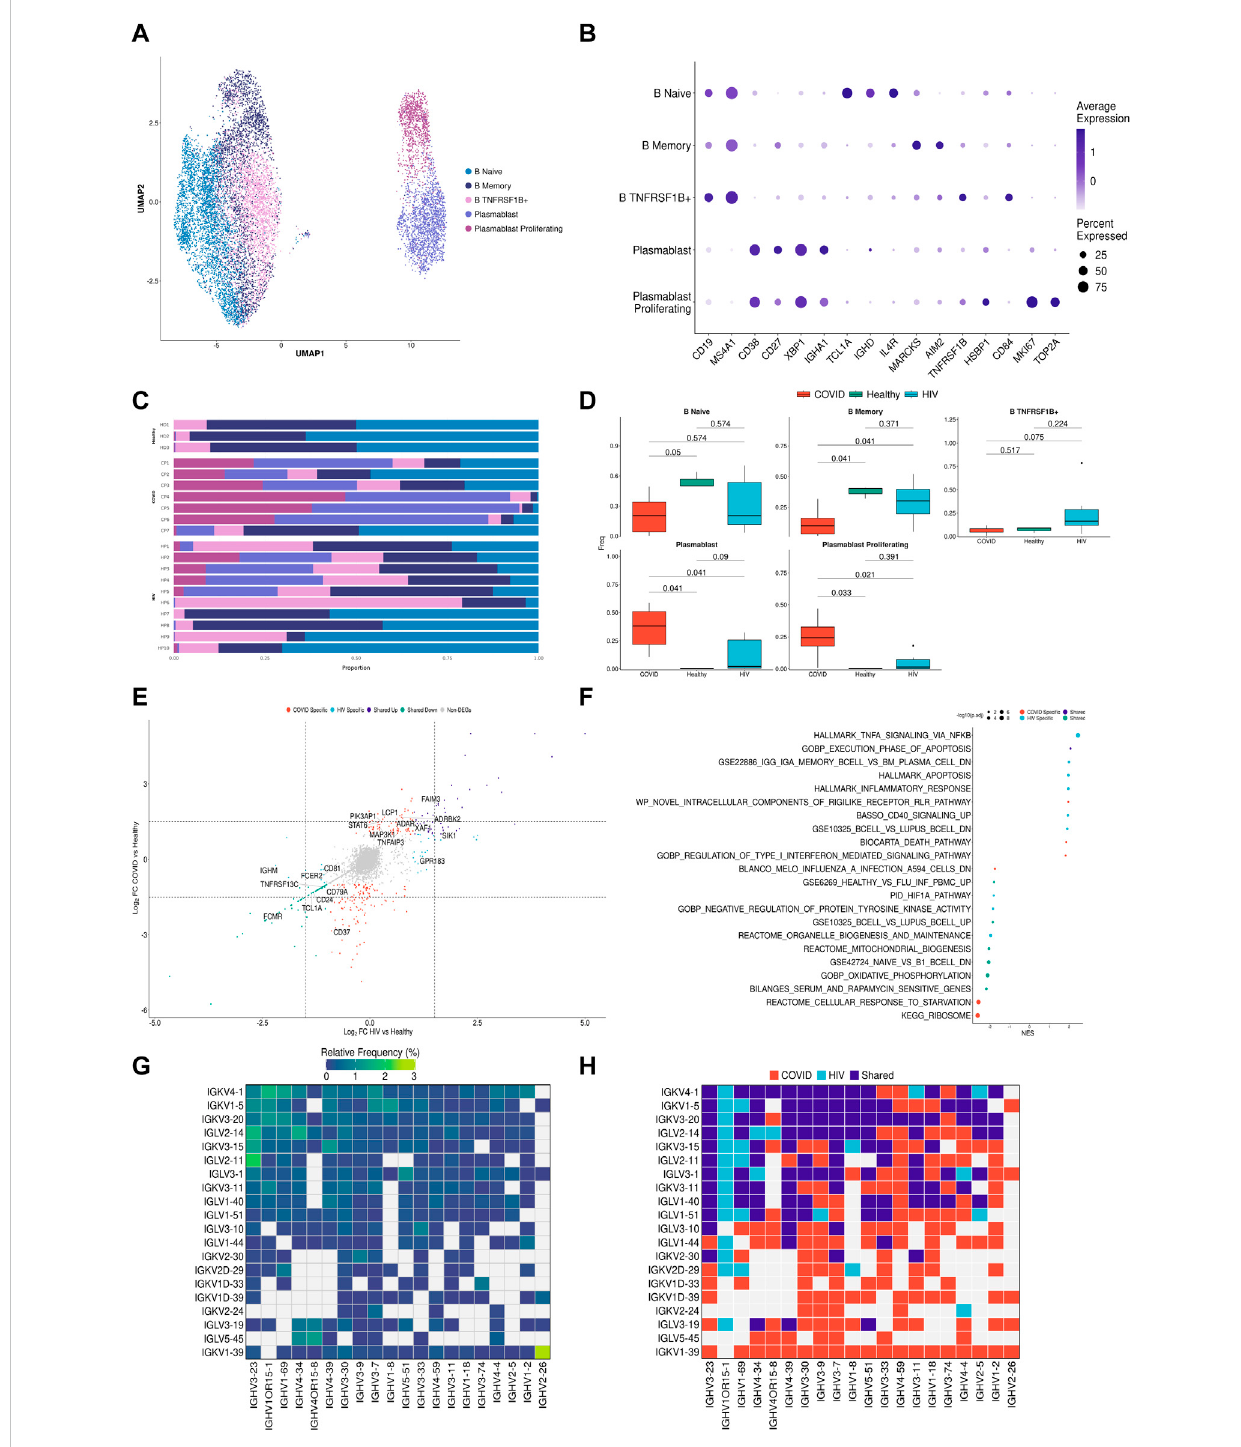
FIGURE 4 B cells in COVID-19 show more robust plasmablast response and antibody diversity relative to HIV-1. (A) UMAP embeddings of B cells colored by subtype. (B) Dot plot of canonical B cell marker expression across subtypes. (C) Stacked bar plots of the relative frequency of subtypes present in each patient. (D) Box plots of the proportions of B cell and plasmablast subsets across each disease condition. Proportions are computed for each patient by dividingtheirnumberofcellsineachBcell/plasmablastsubsetbytheirtotalnumberofBcells+plasmablasts. p -valuesarecomputedwithWilcoxon signed-rank test with Holm-Bonferroni adjustment. (E) Double differential gene expression plot of genes that are differentially expressed between COVID-19 patients compared to healthy controls or differentially expressed between HIV-1 + patients compared to healthy controls. (F) Dot plot of enriched biological pathways from differentially expressed genes that were found to be upregulated (right, positive) or downregulated (left, negative) compared to healthy controls. (G) Heatmap of top 20 light chain ( Y -axis) and heavy chain ( X -axis) combinations found in HIV-1 + and COVID-19 patients. (H) Heatmap indicating the light chain/heavy chain combinations that are either unique to HIV-1 + (light blue), COVID-19 (red), or shared across the two diseases (dark